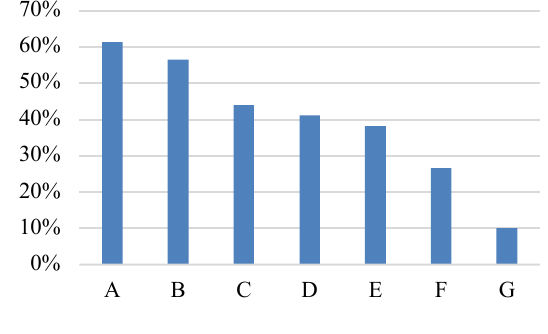
Fig. 7. CE expected benefit.